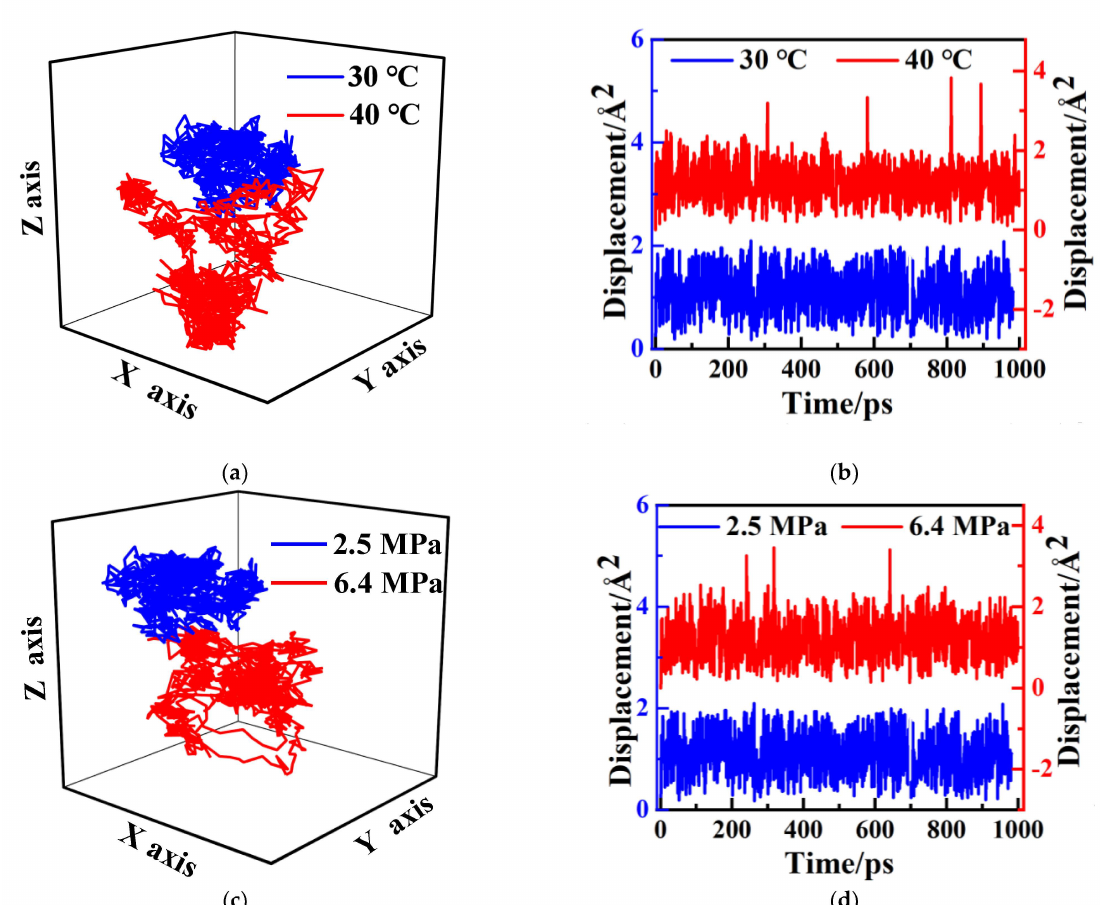
Figure 13. Three-dimensional diffusion trajectory ( a , c ) and displacement ( b , d ) of CH 4 molecules in crude oil-containing PVDF at different service